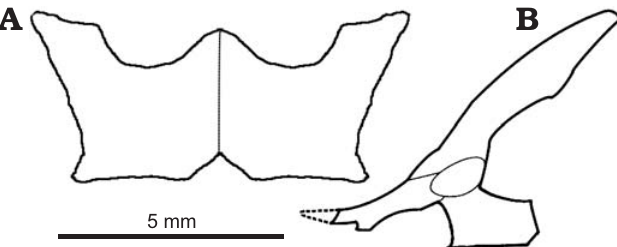
Fig. 8. Reconstruction of pelvis of Slavoia darevskii . A . Based on PIN 3142/358, paired ischia in ventral view. B . Based on ZPAL MgR-I/8, in lateral view; the dashed line marks missing